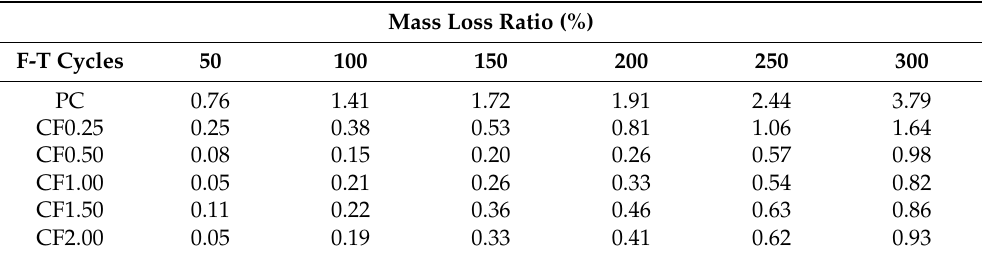
Table 5. Mass loss ratio of the concretes in the frost resistance test.